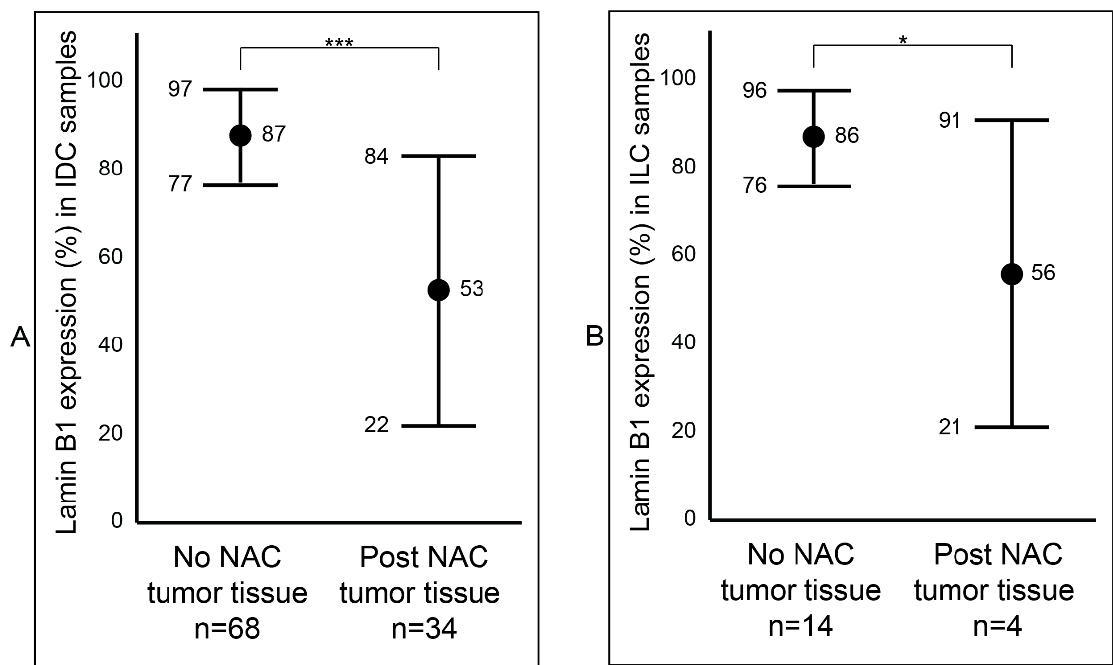
Figure 3. Assessment of lamin B1 protein expression between not exposed to NAC and post- NAC invasive breast carcinoma according to histopathological type. ( A ) In IDC samples. ( B ) In ILC samples. Error bars show mean and ± 1 SD. Statistical differences were calculated using Mann-Whitney test. ***: p value < 0.001; *: p value < 0.05.